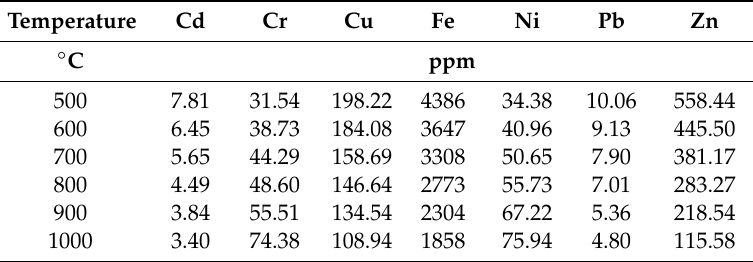
Table 3. Means for the determined